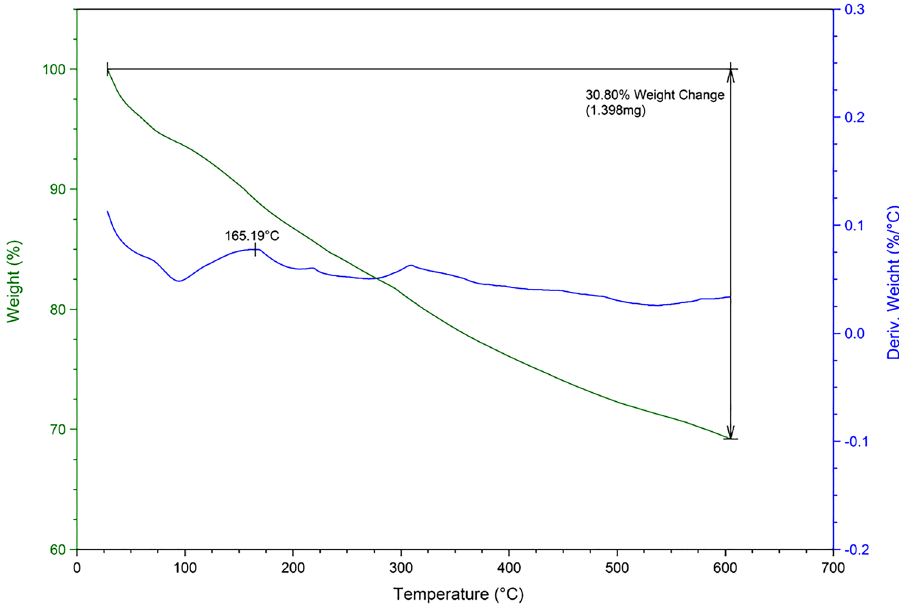
Figure 6. TG/DTG curve of Fe 3 O 4 @SiO 2 @PCLH-TFA.